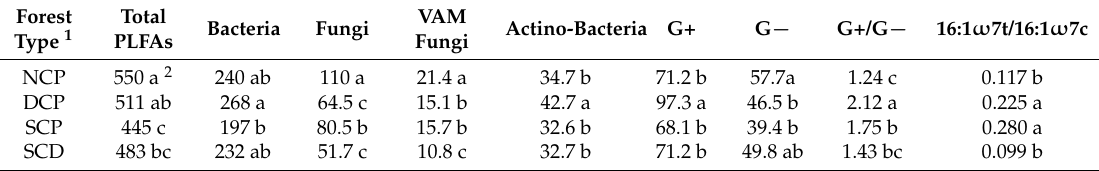
Table 2. Content of phospholipid acid biomarkers (nmol · g − 1 soil) and ratios of biomarkers in natural and managed forest